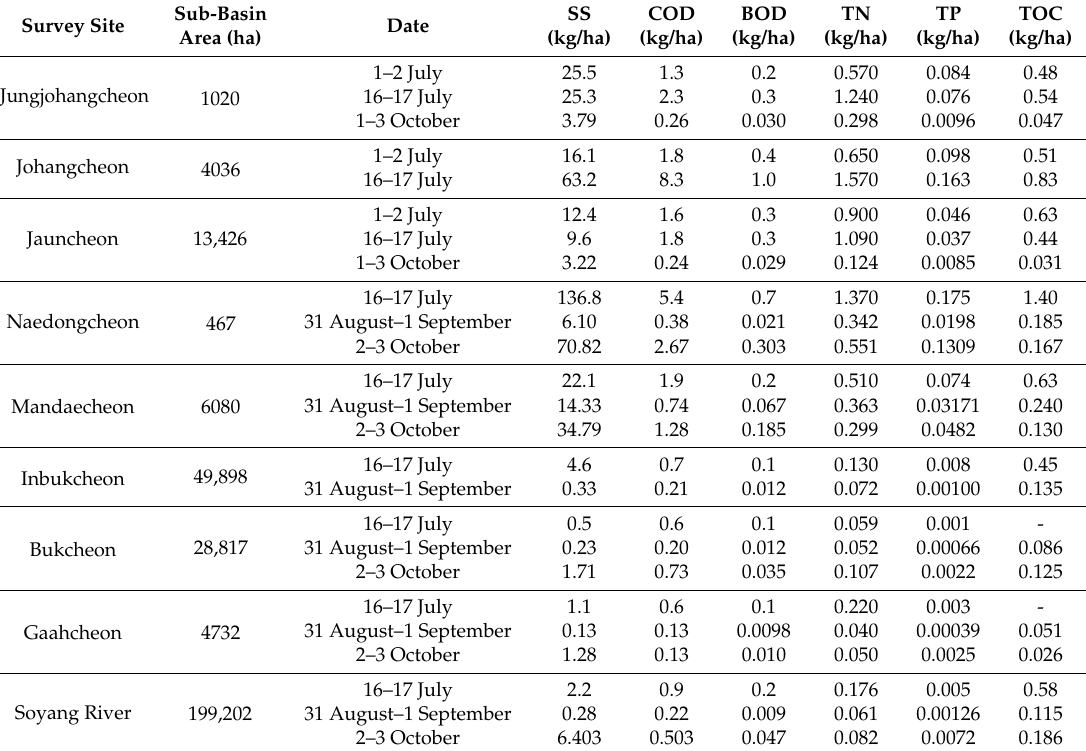
Table 7. Pollutant loads per unit area of each rainfall event in the Lake Soyang watershed. Survey